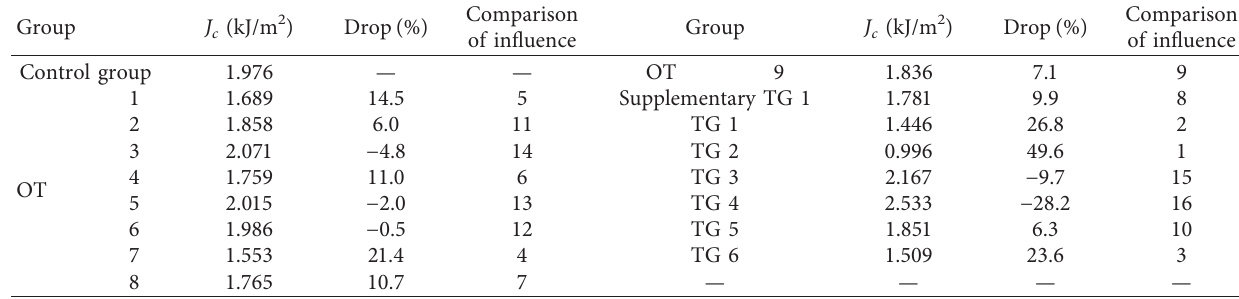
Table 14: Influence degree of various factors on low-temperature performance.